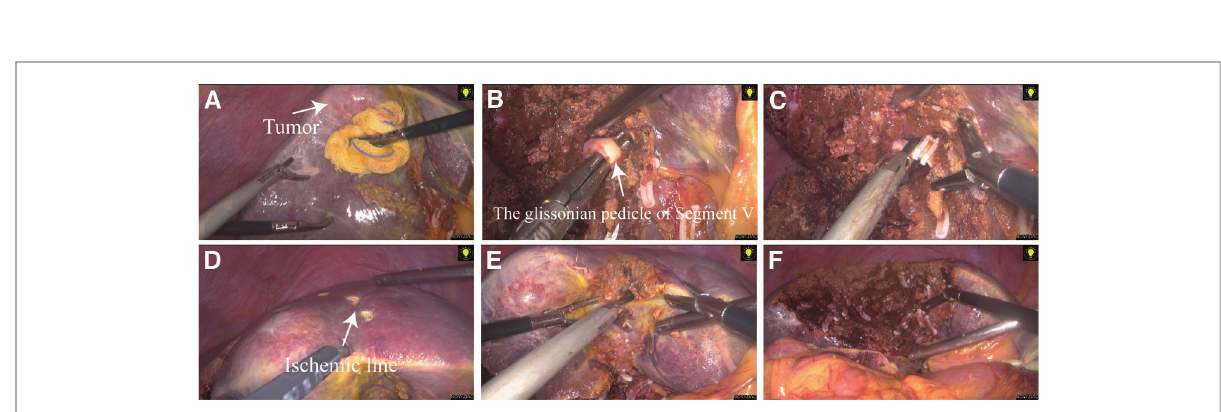
FIGURE 2 Surgical procedure for laparoscopic anatomical segment V resection (using the hepatic parenchymal transection- fi rst approach). ( A ) Anatomical landmarks or intraoperative ultrasound were used to de fi ne the borders of segment V, and a pretransected line was created through ultrasonic dissection. ( B ) The Glissonean pedicle of segment V was dissected free during transection of the liver parenchyma. ( C ) The Glissonean pedicle was clamped and then cut off. ( D ) After inducing ischemia in segment V, we used an electrocoagulation hook to draw a pretransected line based on the ischemic line. ( E ) and ( F ) Complete transection of the remaining liver parenchyma was continued and fi nally, resection of segment V was